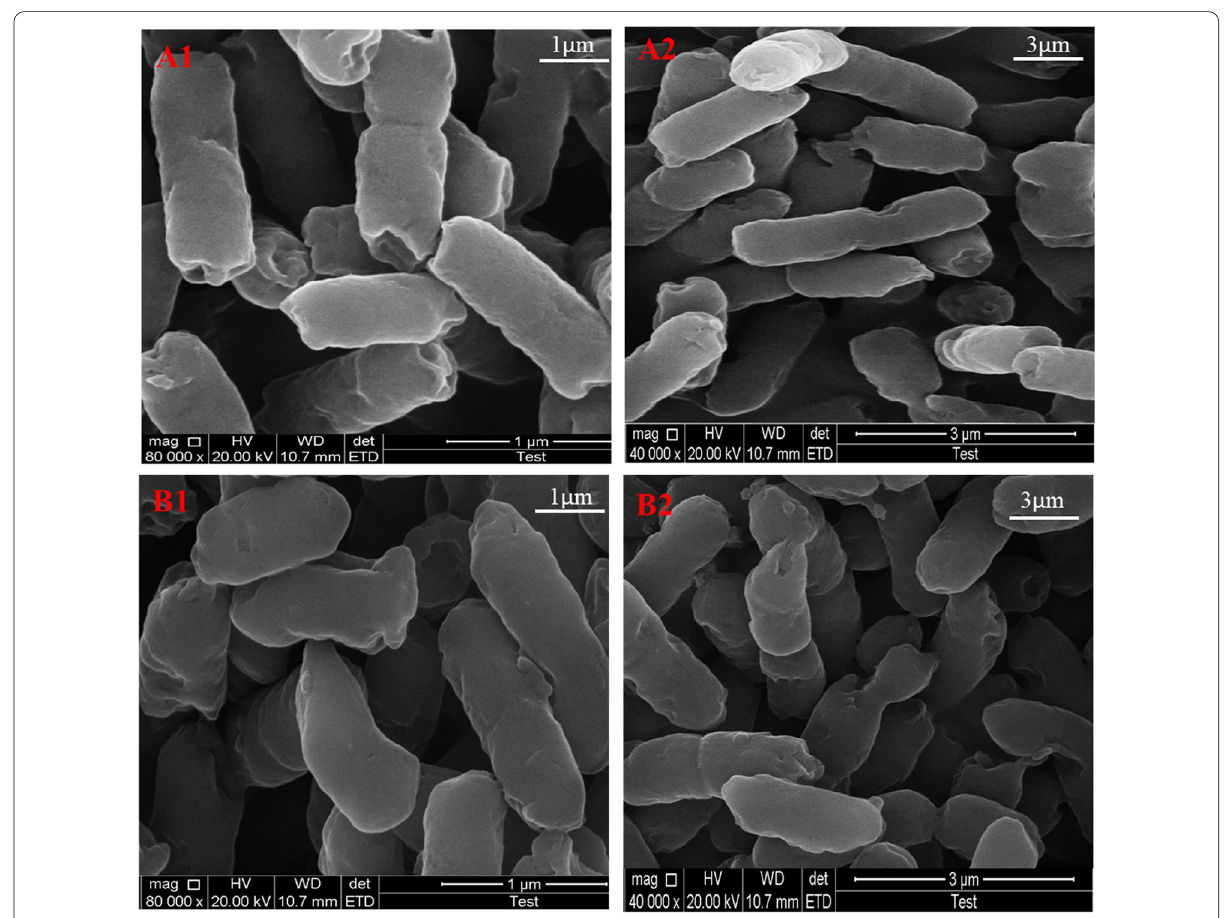
Fig. 3 Scanning electron microscopy image of E. coli W3110 cells under gallic acid stress (gallic acid treatment) and fermentation without stress (control). (A1) Control (magnified 80,000 times); (A2) control (magnified 40,000 times); (B1) gallic acid treatment (magnified 80,000 times); (B2) gallic acid treatment (magnified 40,000